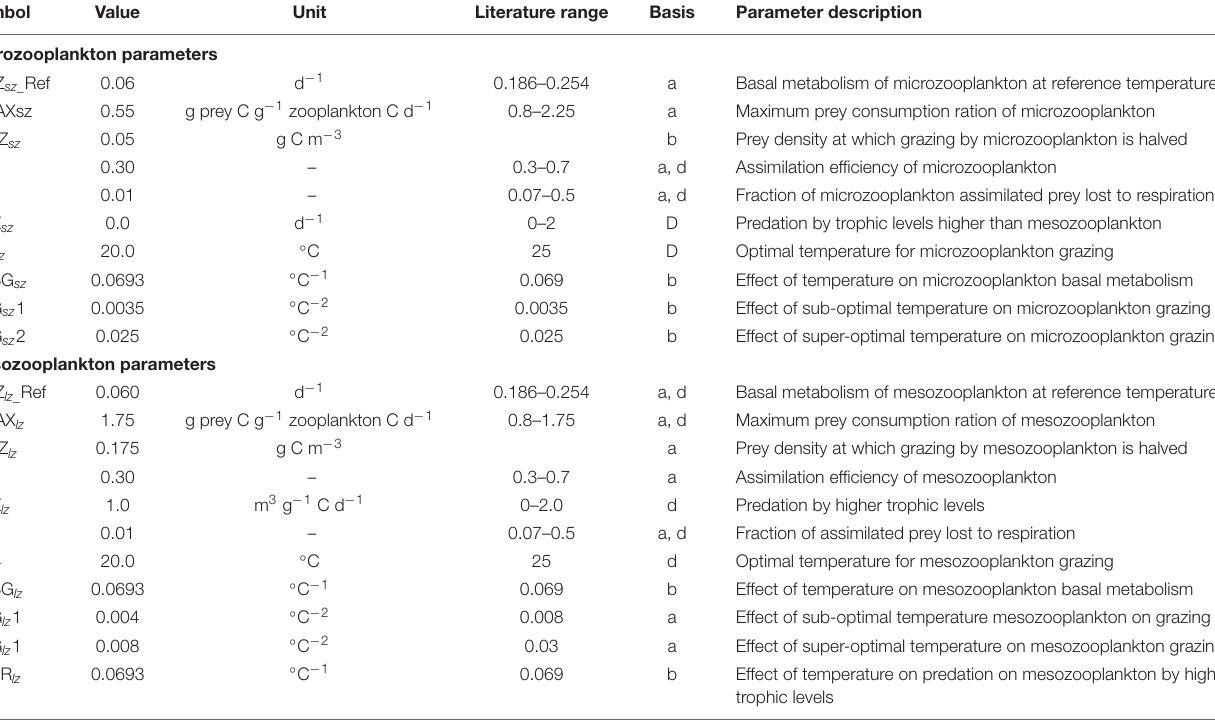
TABLE 2 | A list of major zooplankton parameters (microzooplankton and mesozooplankton as part of the FVCOM-ICM model implementation for the Salish Sea Model. Symbol Value Unit Literature range Basis Parameter